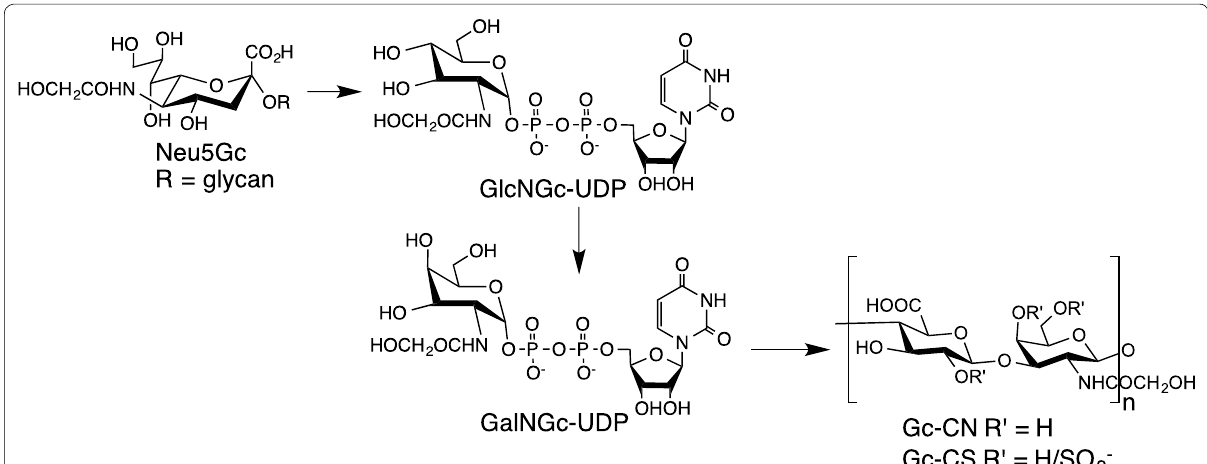
Fig. 2 Neu5Gc is converted to UDP-GlcNGc and ultimately UDP-GalNGc. UDP-GalNGc can then be incorporated into Gc-CN and